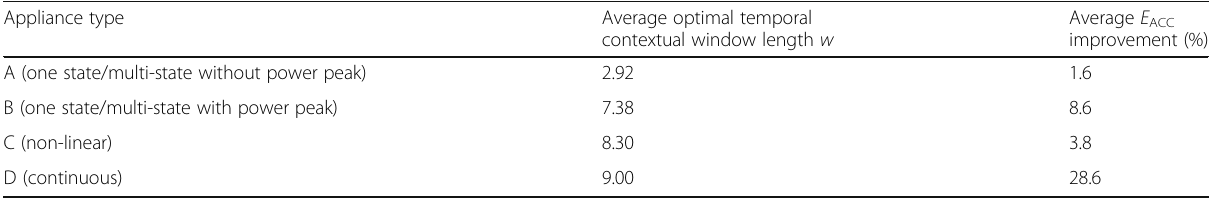
Table 8 Average E ACC improvement and temporal contextual window length for four appliance types (A, B, C and D) Appliance